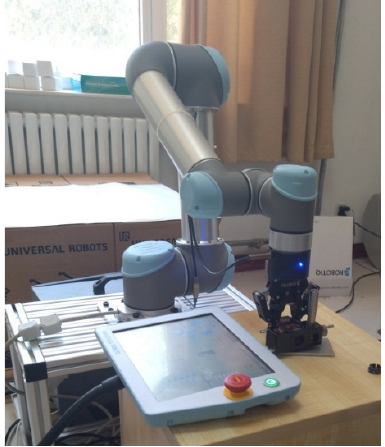
Figure 2. UR5 experimental platform.